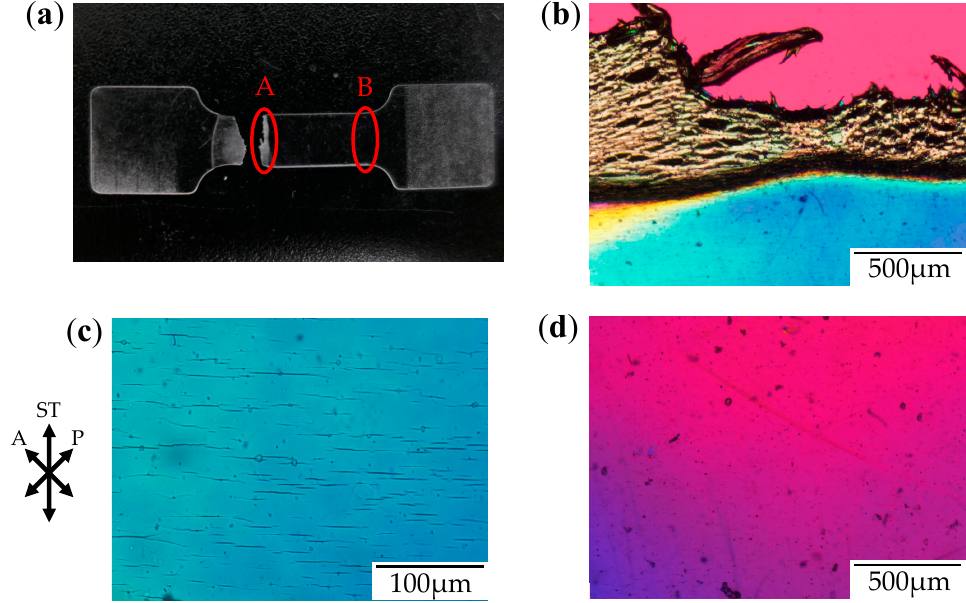
Figure 3. Photograph and polarized optical micrographs of OD-PC obtained by stretching under atmospheric pressure at 120 °C. ( a ) Photograph of the fractured specimen; ( b ) Polarized optical micrograph for region A; ( c ) Magnification of the lower part of ( b ); and ( d ) Polarized optical micrograph for region B.